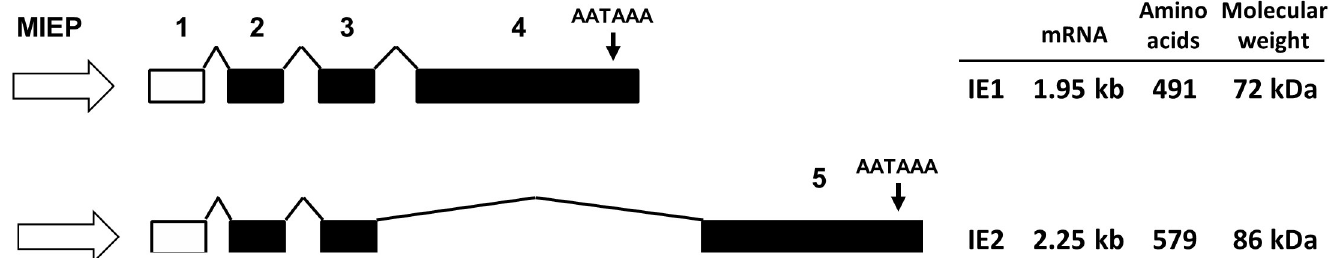
Fig 1. Schematic representation of differential splicing of IE1 and IE2. IE1 and IE2 are derived from the same primary transcript, driven by the major immediate early promoter. Differential splicingand polyadenylation of the terminalexon dictates expressionof IE1 or IE2. Filledboxes indicatecoding exons whereasthe open box representsa